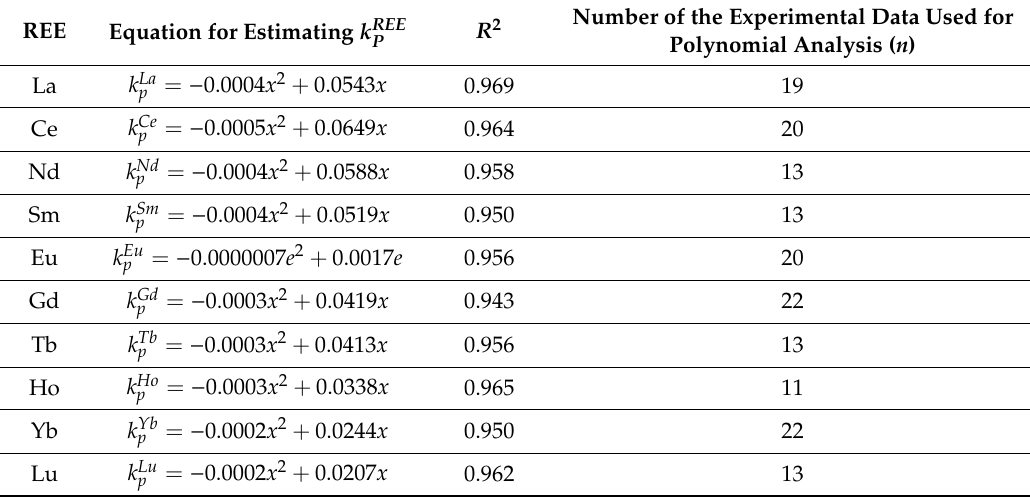
Table 2. Relationship of REE fluid–granite melt partition coe ffi cients ( k REE magmatic